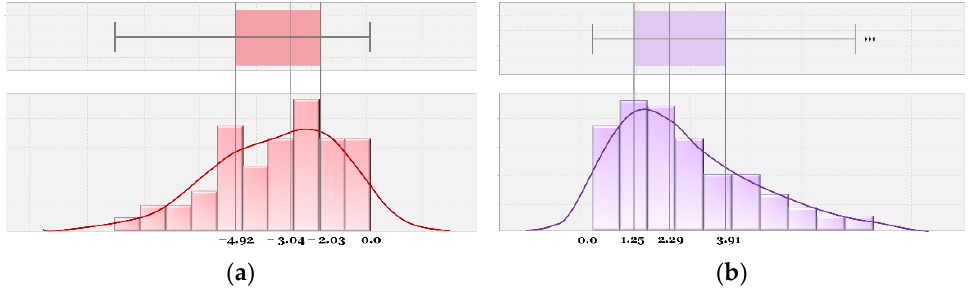
Figure 17. Distributions of PSMs in ( a ) signalized, and ( b ) unsignalized spots.